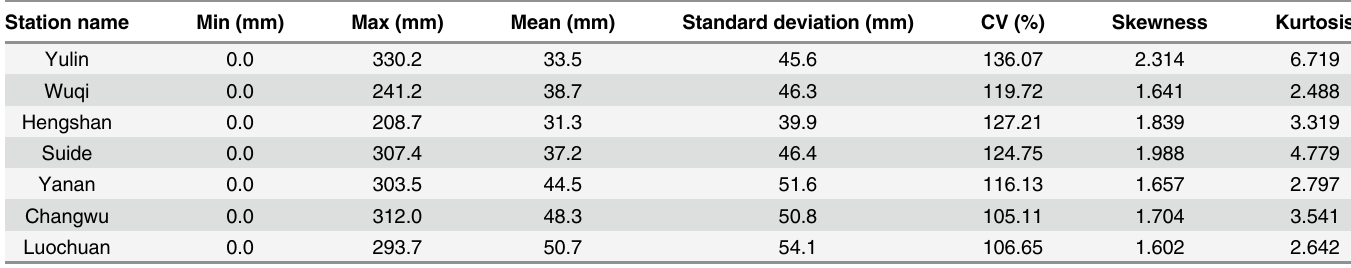
Table 3. Statistical parameters of monthly precipitation time series for the seven synoptic stations during 1957 –